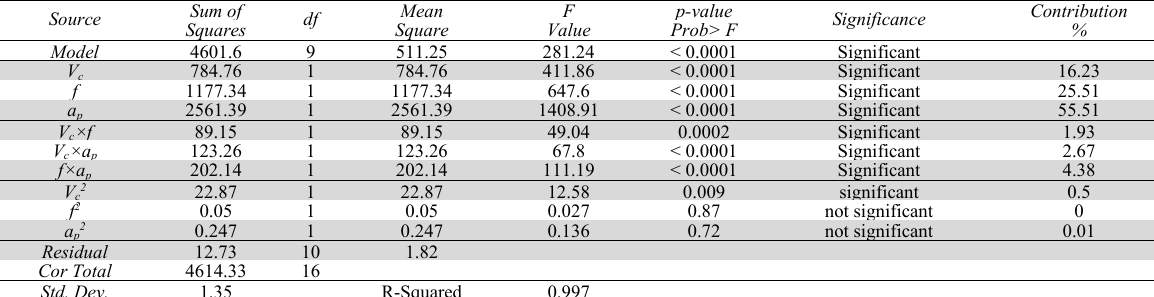
Analysis of variance for Material Removal Rate Source